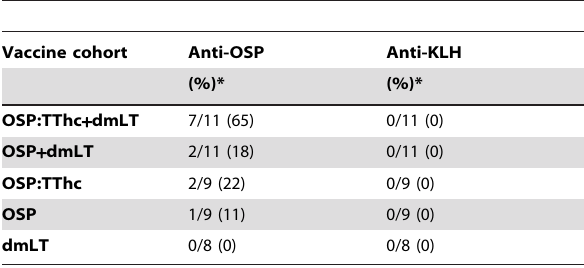
Table 1. OSP-BSA specific IgG memory B cell responses in mice immunized with different vaccine